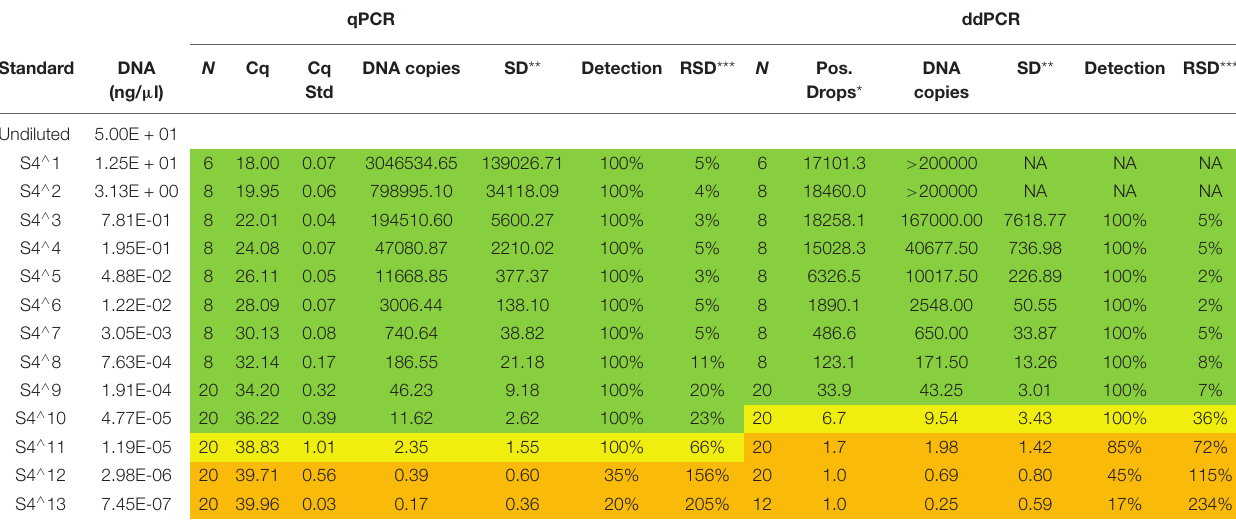
FIGURE 2 | (A) Correlation plot of the estimated DNA copies per reaction of qPCR and ddPCR analysis of gDNA from crayfish tissue using spearman correlation ( R 2 = 0.9, p < 2.2e-16). (B) Logistic regression curve showing probability of gDNA detection against the dilution series number using ddPCR. (C) Logistic regression curve showing probability of detection against the gDNA dilution series number using qPCR. TABLE 2 | The qPCR and ddPCR results for the analysis of the standard dilution used to estimate LOQ and LOD for qPCR (Rusch et al., 2020) and ddPCR (this study) using the same